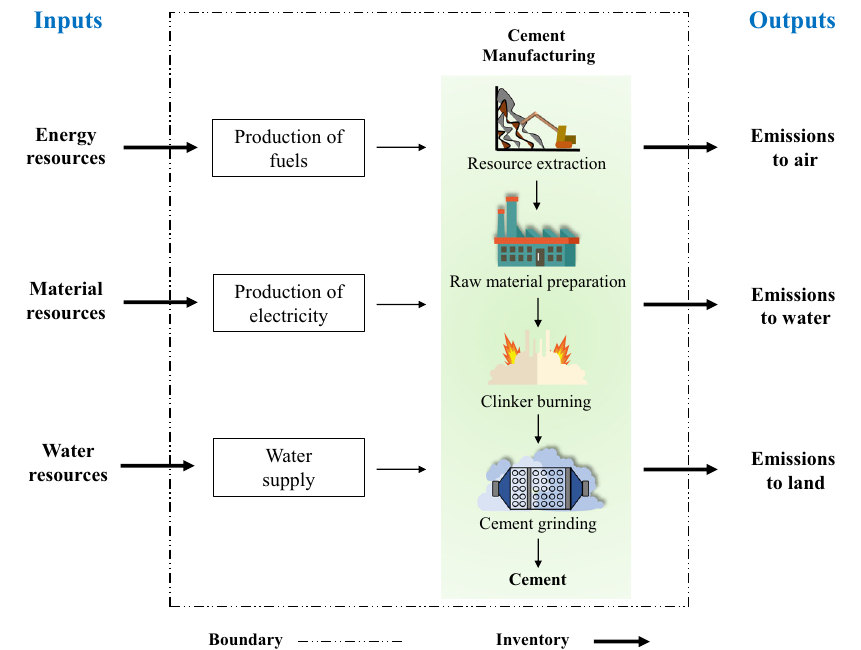
Fig. 5 Life-cycle assessment framework for cement manufacturing. The value chain of cement manufacturing includes four steps: resource extraction, raw material preparation, clinker burning, and cement grinding. The inventory comprises two aspects: the inputs of energy, material, and water; the outputs of emissions to air, water, and land. Table 1 The national environmental impact value by the scenario in